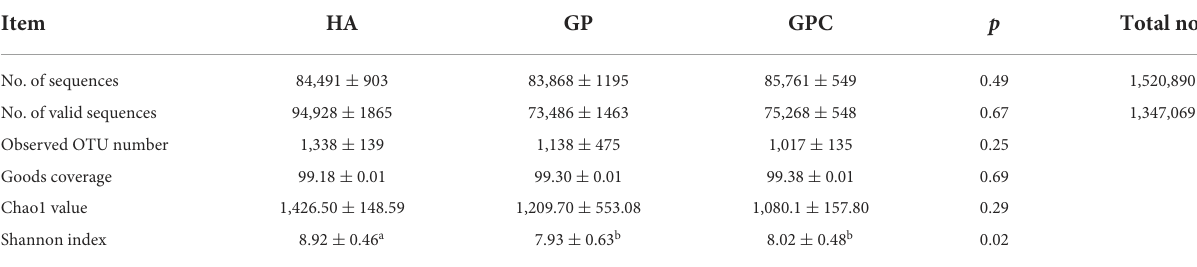
TABLE 3 Diversity indices of ruminal microbiome of lambs fed non-pelleted native grass hay without or with concentrate or